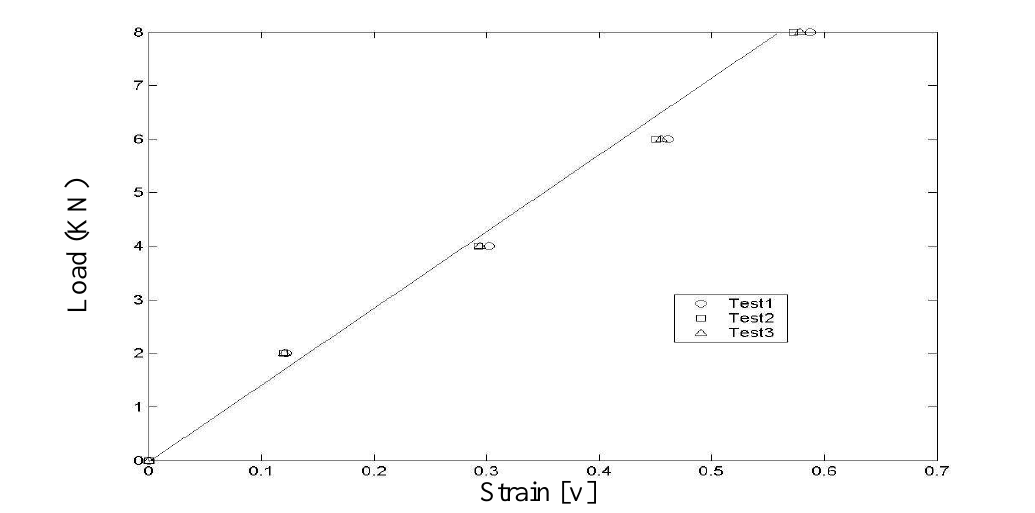
Figure 11. Illustration of the repeatability of the